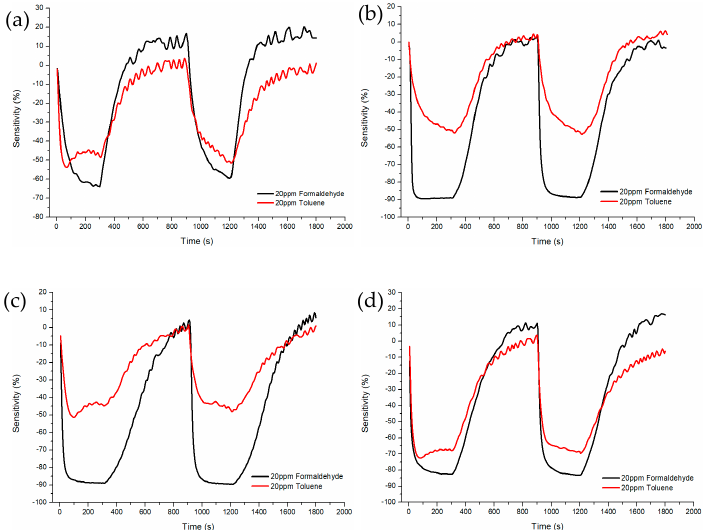
Figure 10. Sensitivity and recovery characteristics according to concentration (20 ppm) of formalde- hyde and toluene gas of ZnO-TiO 2 gas sensor. ( a ) ZnO(90%)-TiO 2 (10%) ( b ) ZnO (95%)-TiO 2 (5%) ( c )